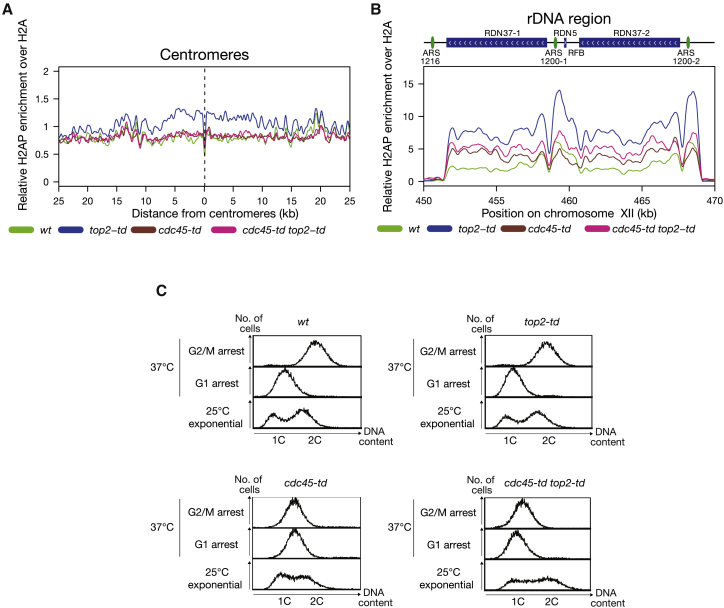
Depletion of Top2 during S Phase Causes H2AS129P Enrichment at Centromeres and over the rDNA Repeats in a Replication-Fork-Dependent Manner(A) The relative enrichment of H2AS129P over H2A ChIP around all centromeres in cdc45-td-depleted cells either with WT expression of Top2 in cdc45-td (brown) or depleted for Top2 and Cdc45 (pink) in cdc45-td top2-td cells, both released into the cell cycle under the restrictive conditions. Data for WT (green) and top2-td cells (blue) from Figure 1 are shown for comparison. Graph shown is generated from a pile up of the profiles of all centromeres and is an average of two repeats.(B) The relative enrichment of H2AS129P over H2A ChIP across the rDNA repeats in cdc45-td-depleted cells either with WT expression of Top2 in cdc45-td (brown) or depleted for Top2 and Cdc45 (pink) in cdc45-td top2-td cells, both released into the cell cycle under the restrictive conditions. Data for WT (green) and top2-td cells (blue) from Figure 1 are shown for comparison. Graph shown is an average of two repeats.(C) FACS analysis of DNA content for one repeat of each of the indicated stages of the experiment. Second repeat is shown in Figure S7.